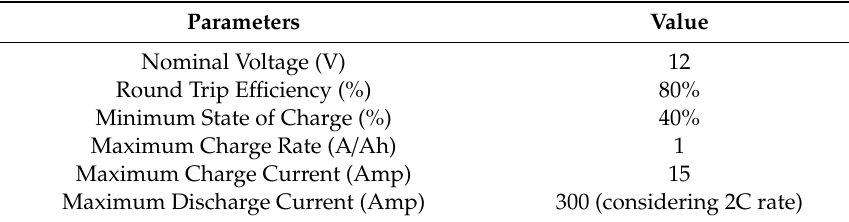
Table 2. Parameters for Kinetic Battery Model in Homer